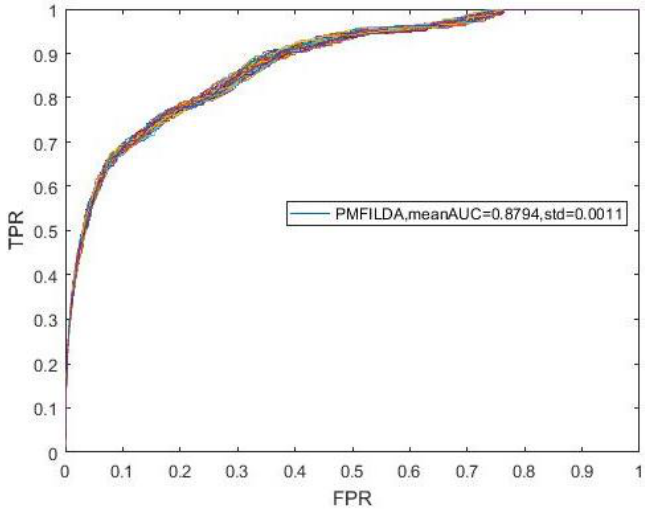
Figure 3. ROC curves for PMFILDA.